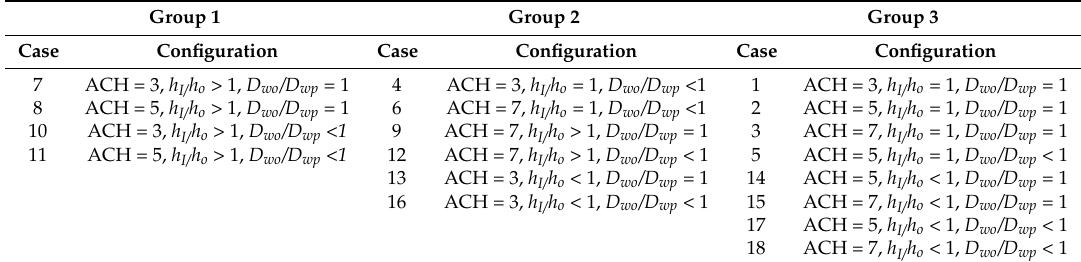
Table 3. Details of the configurations of the cases in each